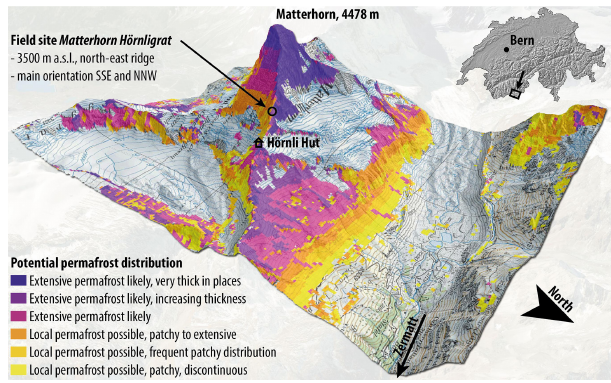
Figure 3. Three-dimensional overview of the Hörnligrat field site on the northeast ridge of the Matterhorn in Valais, Switzer- land (based on http://www.map.geo.admin.ch, Google Earth and SRTM). Colors indicate the potential permafrost distribution (FOEN, 2005). At this field site, extensive permafrost with a thin active layer is expected on the north side of the ridge. On the south side of the ridge, local permafrost is possible with a considerable active